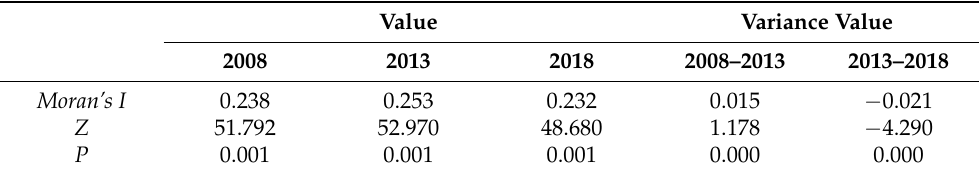
Table 3. Changes in the global spatial autocorrelation of land-use conflict in Lin’an District, 2008– 2018.